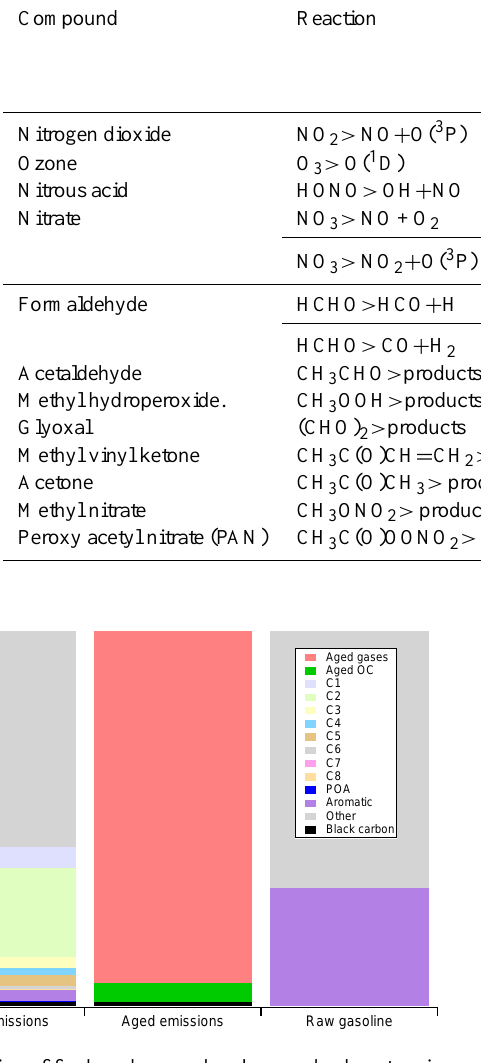
Fig. 7. Composition of fresh and smog chamber aged exhaust emis- sions (CO 2 normalised) from a Euro 5 gasoline light-duty vehicle (Exp. 2), and raw gasoline fuel. Data are presented as a carbon